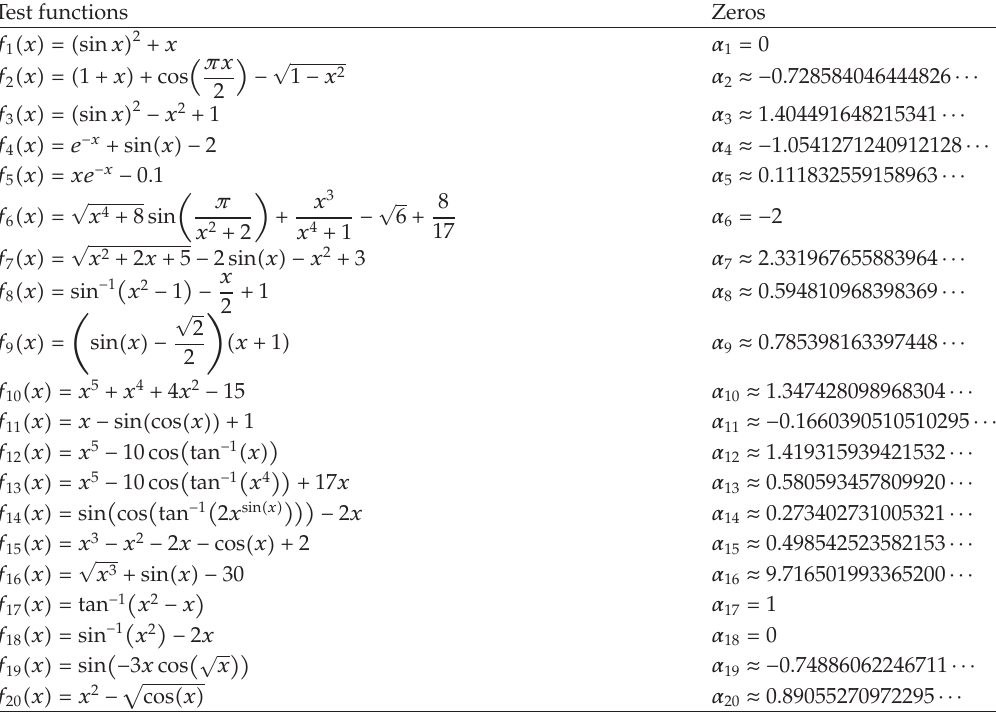
Table 1: The examples considered in this